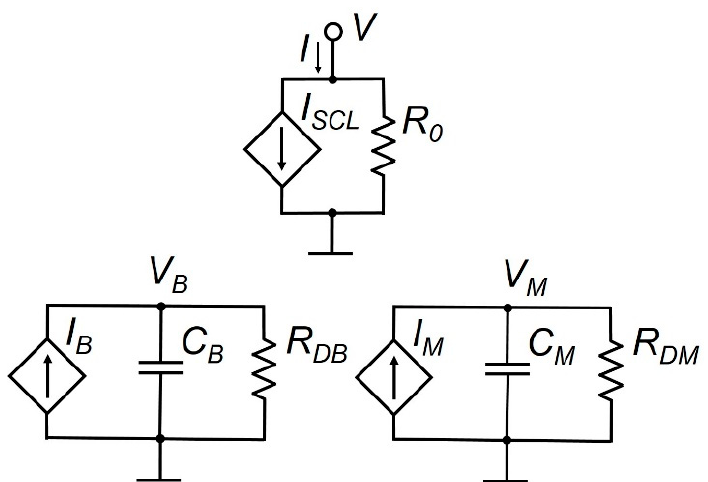
Figure 1. Equivalent circuit of a metal oxide memristive element.